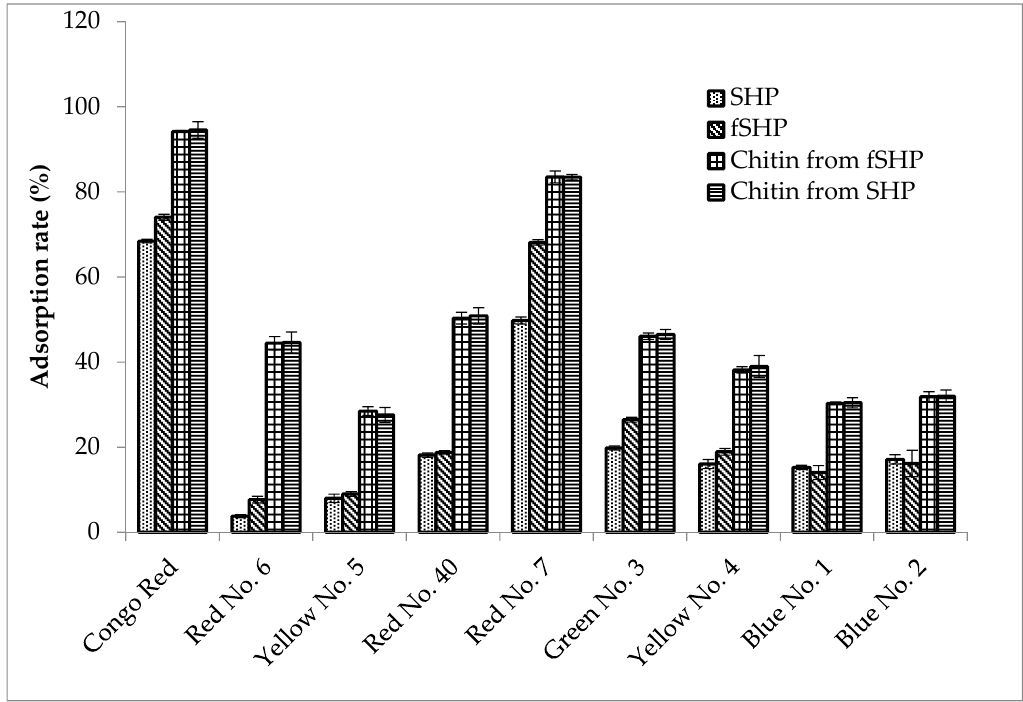
Figure 6. Dye adsorption ability of SHP, fermented SHP (fSHP), chitin from SHP, and chitin from fSHP. The error bar represents the standard deviation of three repetitions.